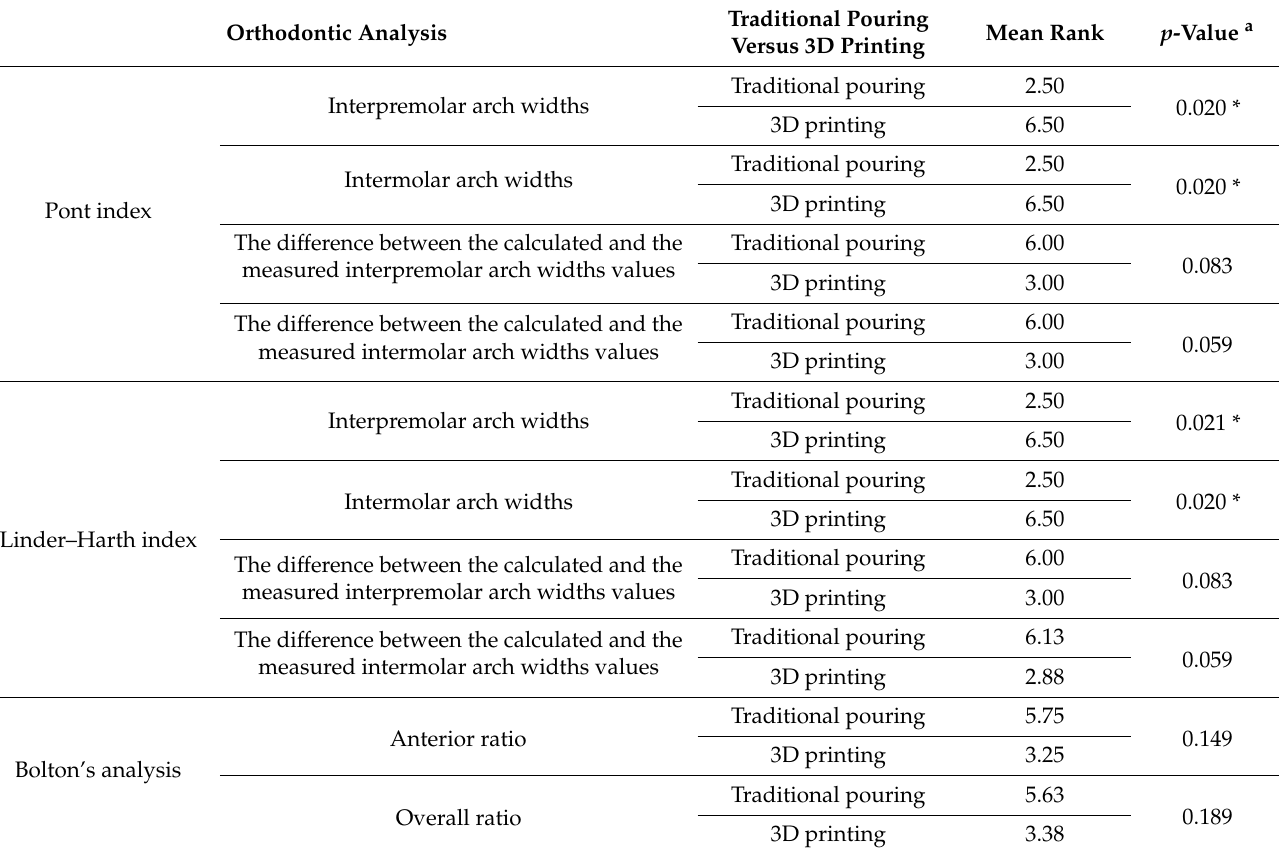
Table 4. Traditional pouring versus 3D printing comparison of the analyzed indices using the Mann–Whitney U test.